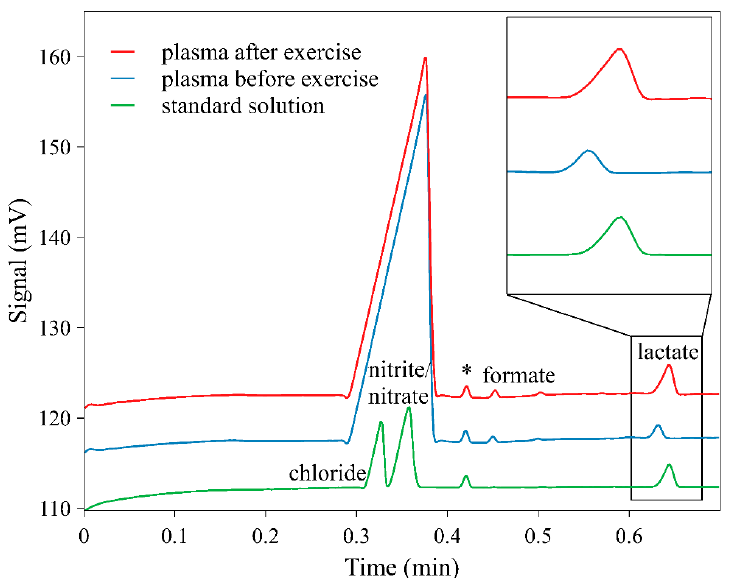
Figure 1. Separation of a standard solution of chloride, nitrate, nitrite, and lactate and blood plasma samples separated using the blood plasma separation device. Separation conditions: BGE 10 mM HIS, 15 mM GLU, 30 µM CTAB, pH 4.6, injection: hydrodynamic, 30 s/10 cm, separation voltage − 18 kV, separation current 6.1 µA. (*) peak is the impurity from TAPS diluent.